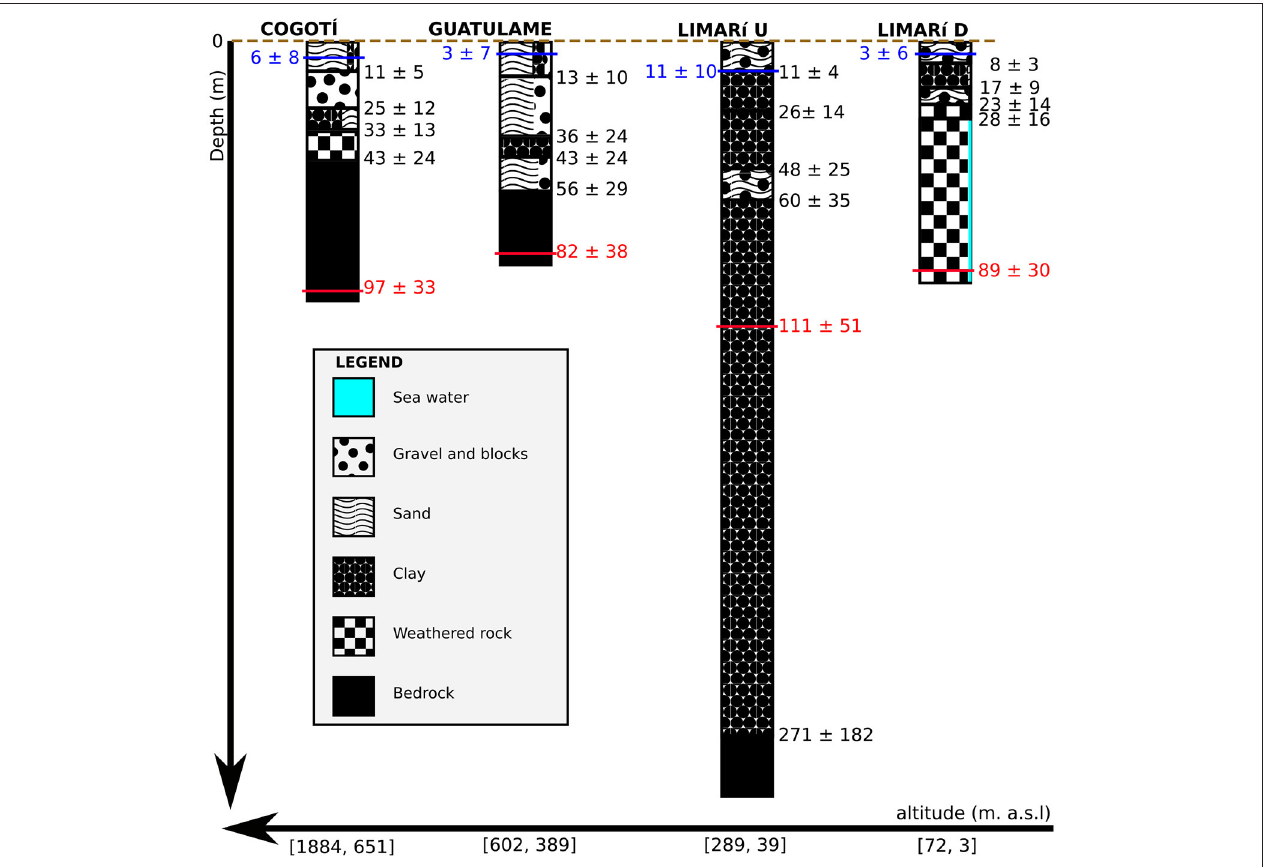
FIGURE 10 | Example of hydrostratigraphic characterizations for four sectors of hydrogeological continuity. The sectors are displayed in a decreasing topographic order. Together with the average depth of the bottom of the modeled layers and their compositions, in blue are represented the average depth to the water table ( Figures 4B–E ) and in red the average DOI of TEM soundings. Each quantity is given with its total variability which is a combination of its spatial standard deviation and its average uncertainty. The letters U and D stands for Upstream and Downstream of Altos de